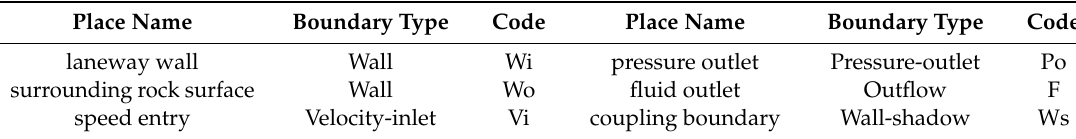
Table 7. Boundary condition setting table.